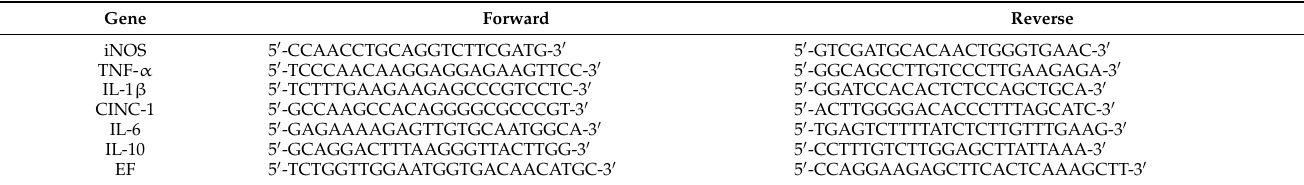
Table 1. List of primer sets for real-time